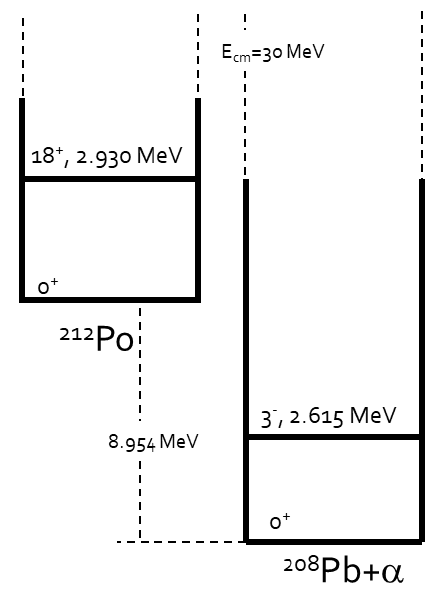
Fig. 1. 208 Pb and 212 Po level scheme.